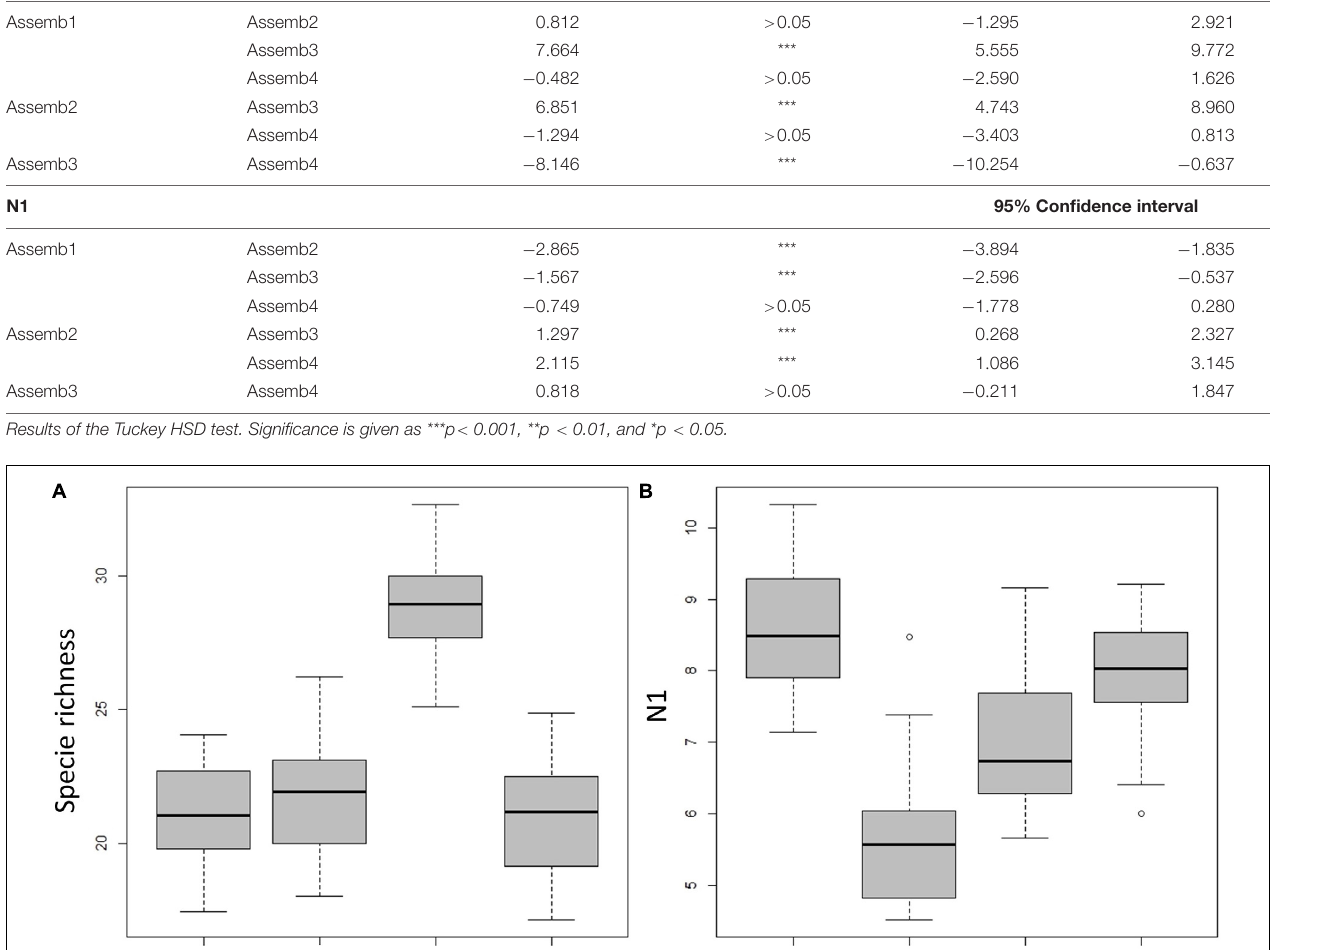
the Mediterranean Sea (see Farriols et al., 2019), which further confirms our findings for